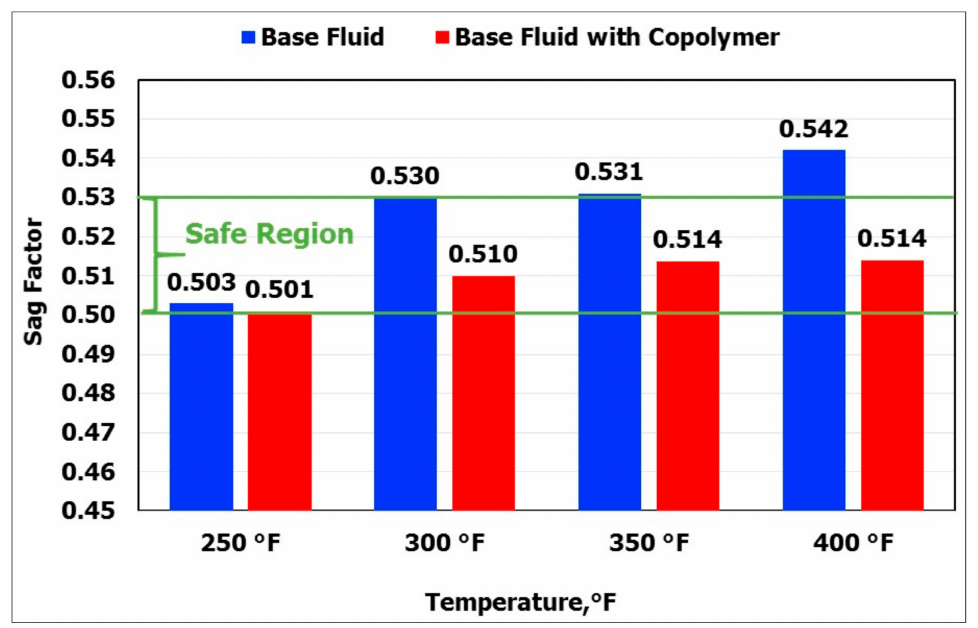
Figure 3. Static vertical sag factor for the drilling fluid with and without the copolymer at different